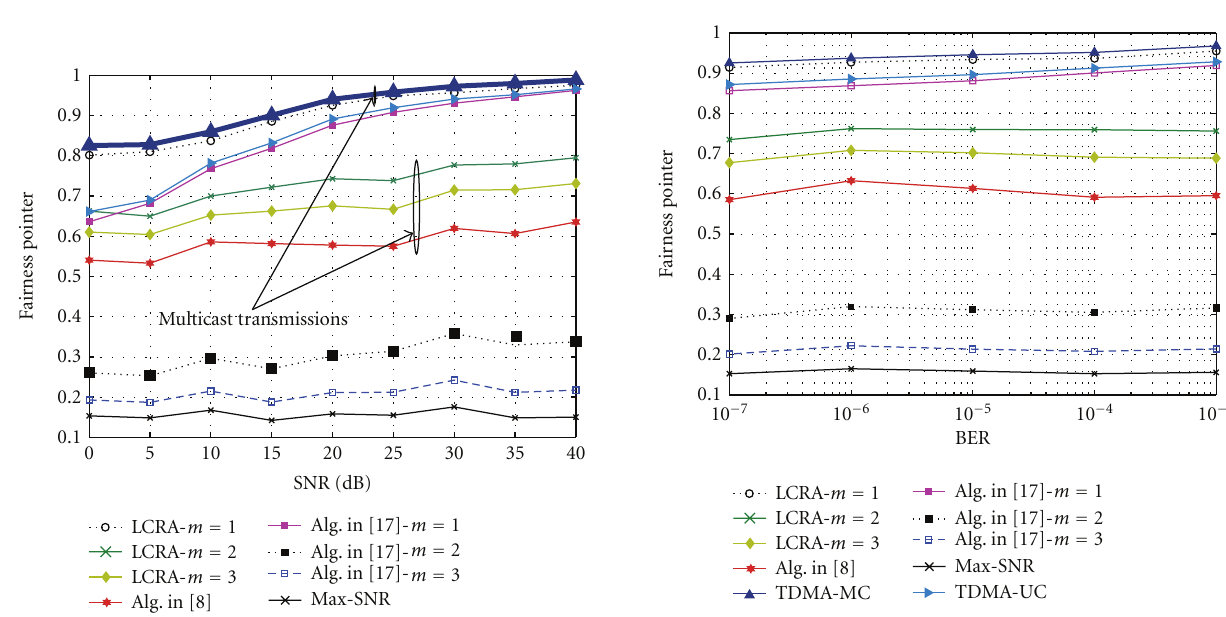
Figure 3: System data rate versus average SNR.